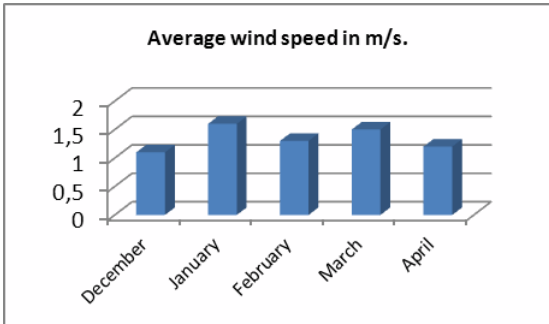
Figure 5. Average wind speed in m/s